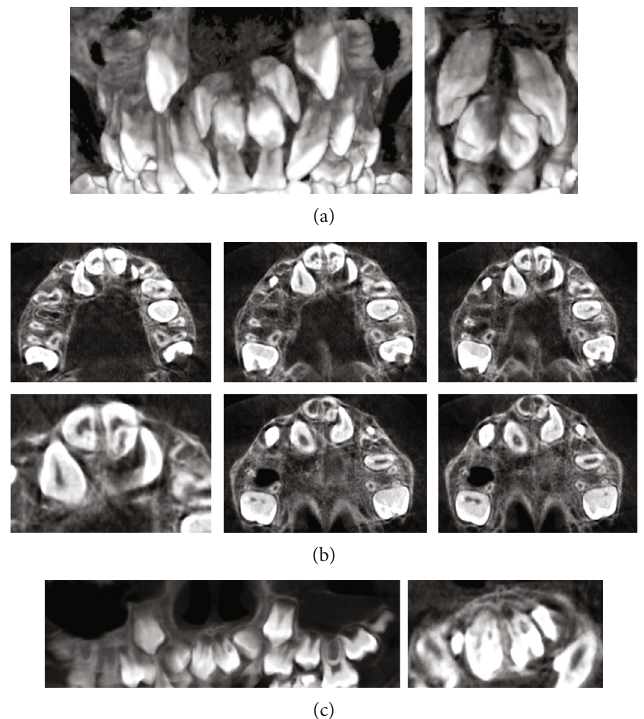
Figure 1: CBCT examination: (a) vestibular and palatal views, (b) transverse sections, and ( с ) frontal